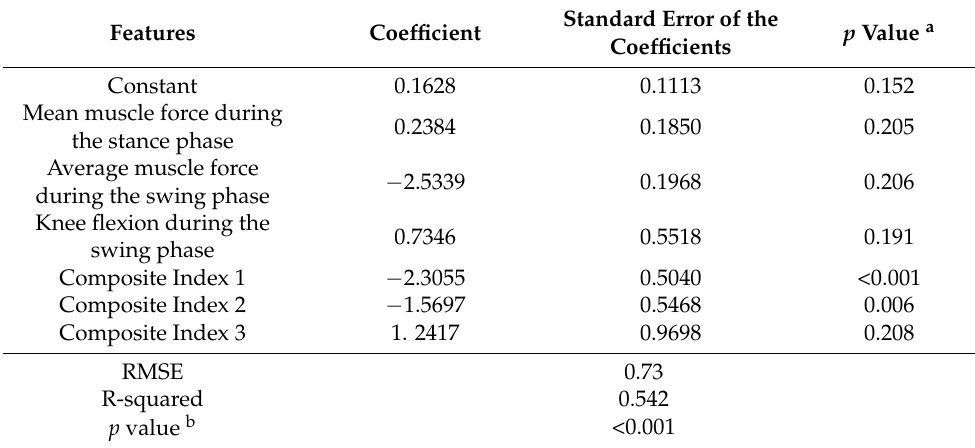
Table 4. Multivariable linear regression model of all